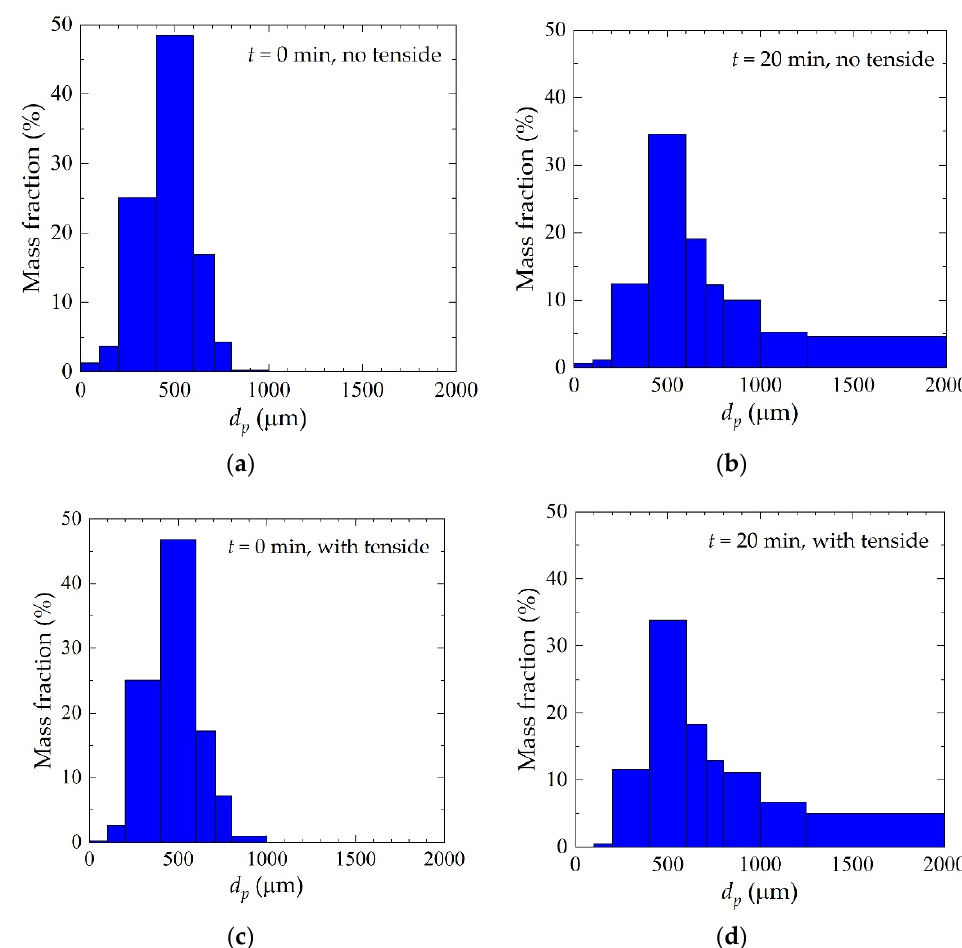
Figure 3. Experimental mass-based histograms of particle size distribution: ( a ) initial particle size distribution for the test without surfactant addition; ( b ) particle size distribution after t = 20 min for the test without surfactant addition; ( c ) initial particle size distribution for the test with surfactant addition; ( d ) particle size distribution after t = 20 min for the test with surfactant addition.